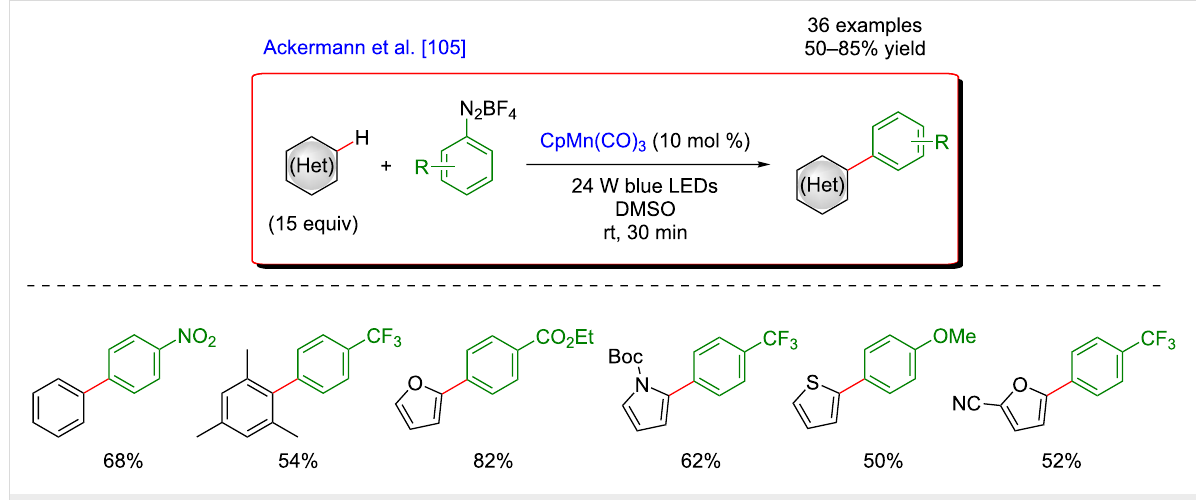
Figure 44: Undirected C–H arylation of (hetero)arenes via dual manganese/photoredox catalysis.